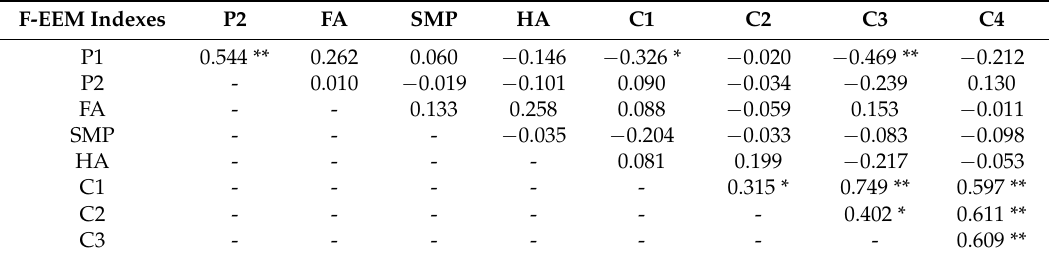
Figure 3. The removal efficiency (%) of fluorescence excitation-emission (F-EEM) components derived from EEM datasets in the studied WWTPs. C1: H-Terres (humic acid-like terrestrial); C2: P-Tryp (protein-tryptophan), C3: FA (Fulvic Acid-like), C4: H-microbial. Table 2. Pearson correlation coefficients (r) and associated significance level between the removal efficiencies of different F-EEM indexes in the investigated WWTPs (n =